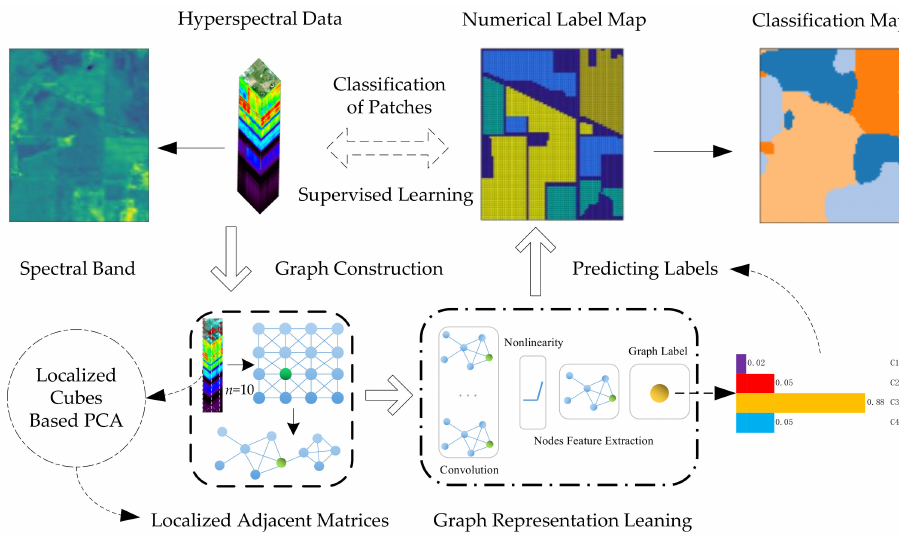
Figure 2. The presented graph representation learning framework for HSI classification with the localized graph convolu- tional filter. Here, the localized feature cubes were created by using a principal component analysis (PCA)